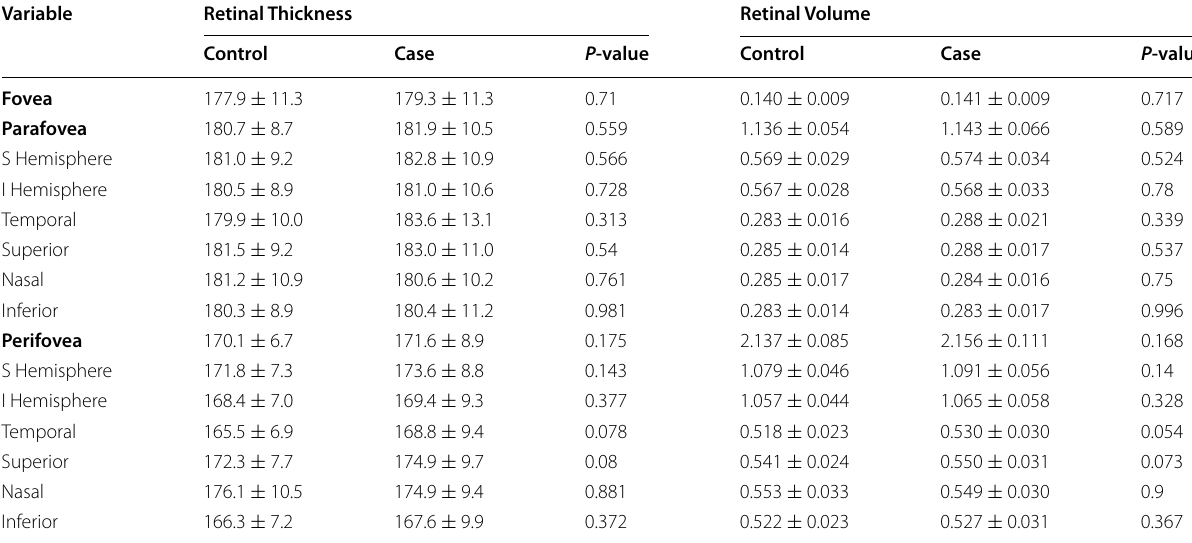
25) and Control Group ( N =